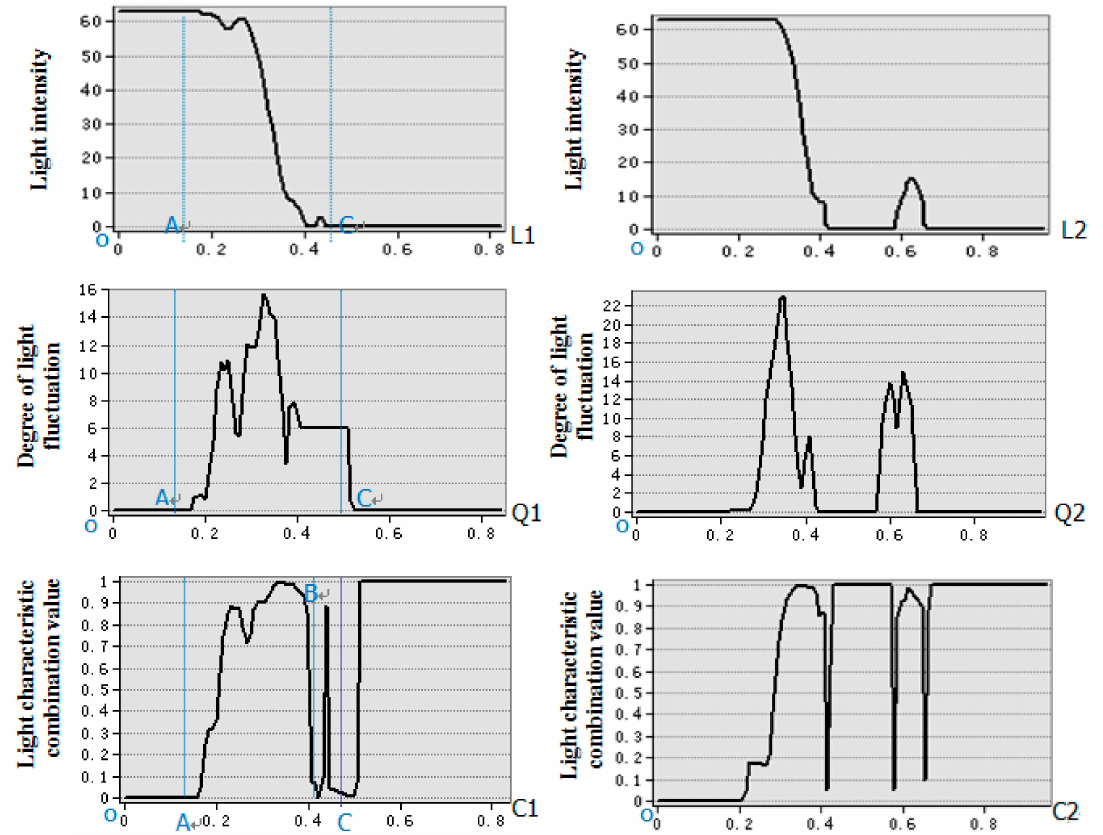
Figure 7. Graph of light intensity ( L1 , L2 ), degree of light intensity fluctuation ( Q1 , Q2 ), and light characteristic combination value ( C1 , C2